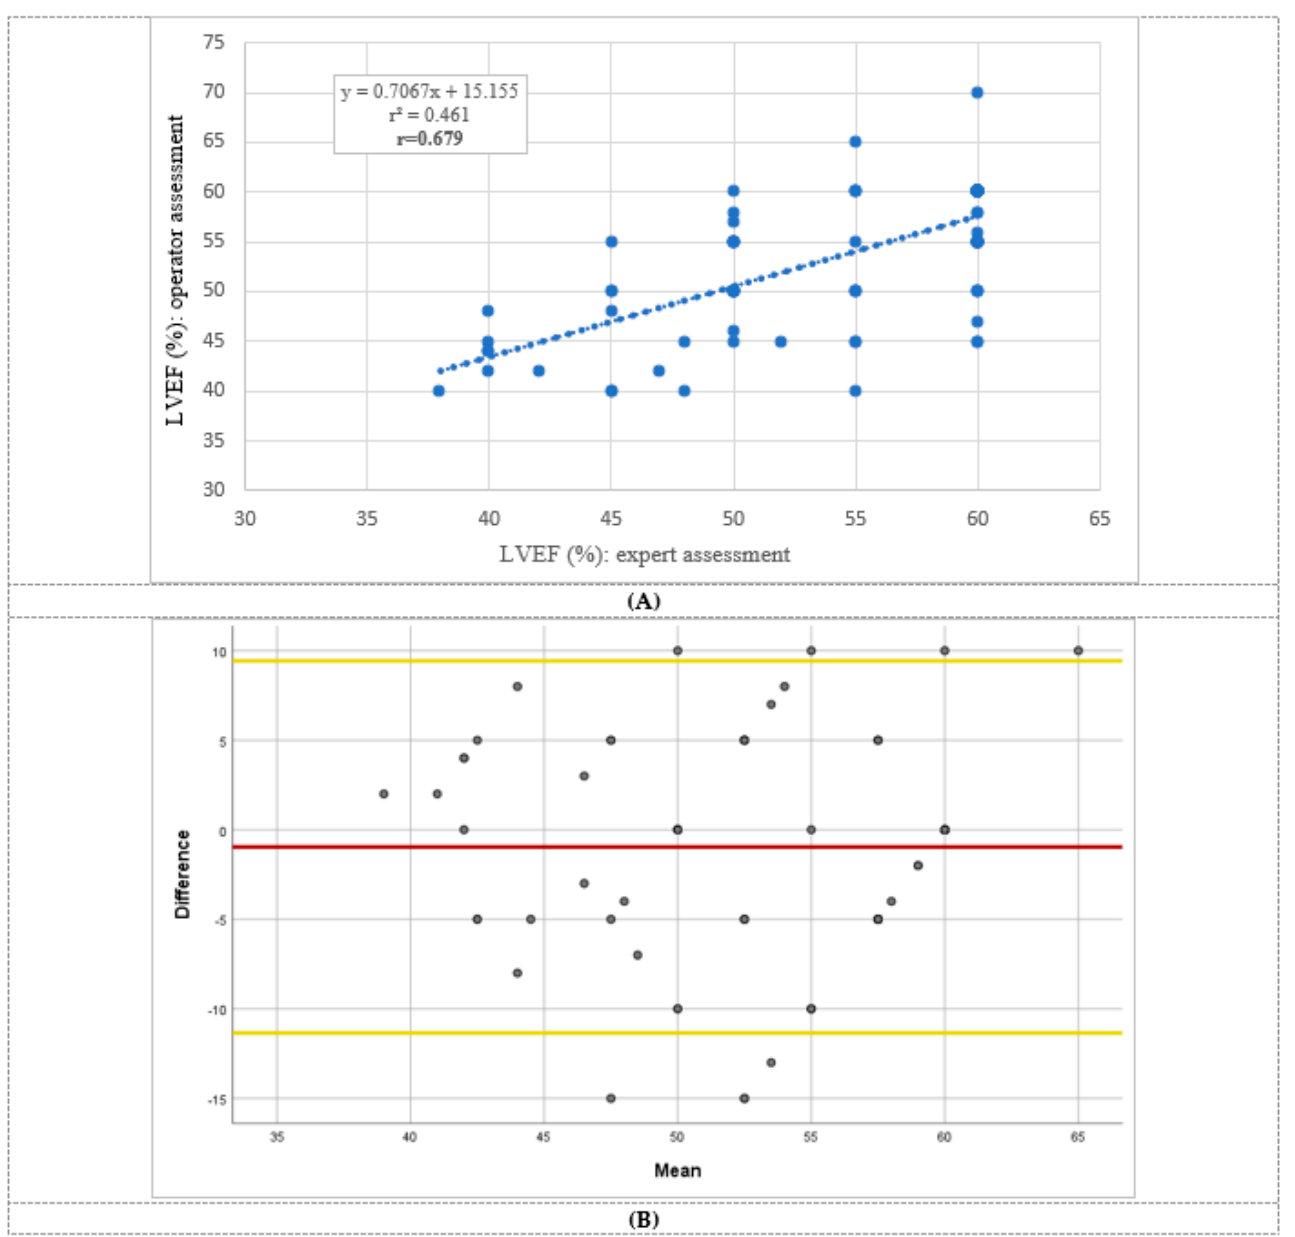
Figure 2. Left ventricular ejection fraction (LVEF) assessment correlation and agreement between the operator and the echocardiographer. ( A) : LVEF correlation between the operator and the echocardiographer; Pearson correlation coefficient = 0.679 ( p < 0.001). ( B ): LVEF assessment agreement using the Bland–Altman analysis revealed a mean bias of − 0.96 as represented by the red line with limits of agreement ranging from 9.43 to − 11.35 as represented by the yellow lines ( p = 0.075). Abbreviations: LVEF, left ventricular ejection fraction. Reproduced from Dadon et al [34]. with permission from Wiley.